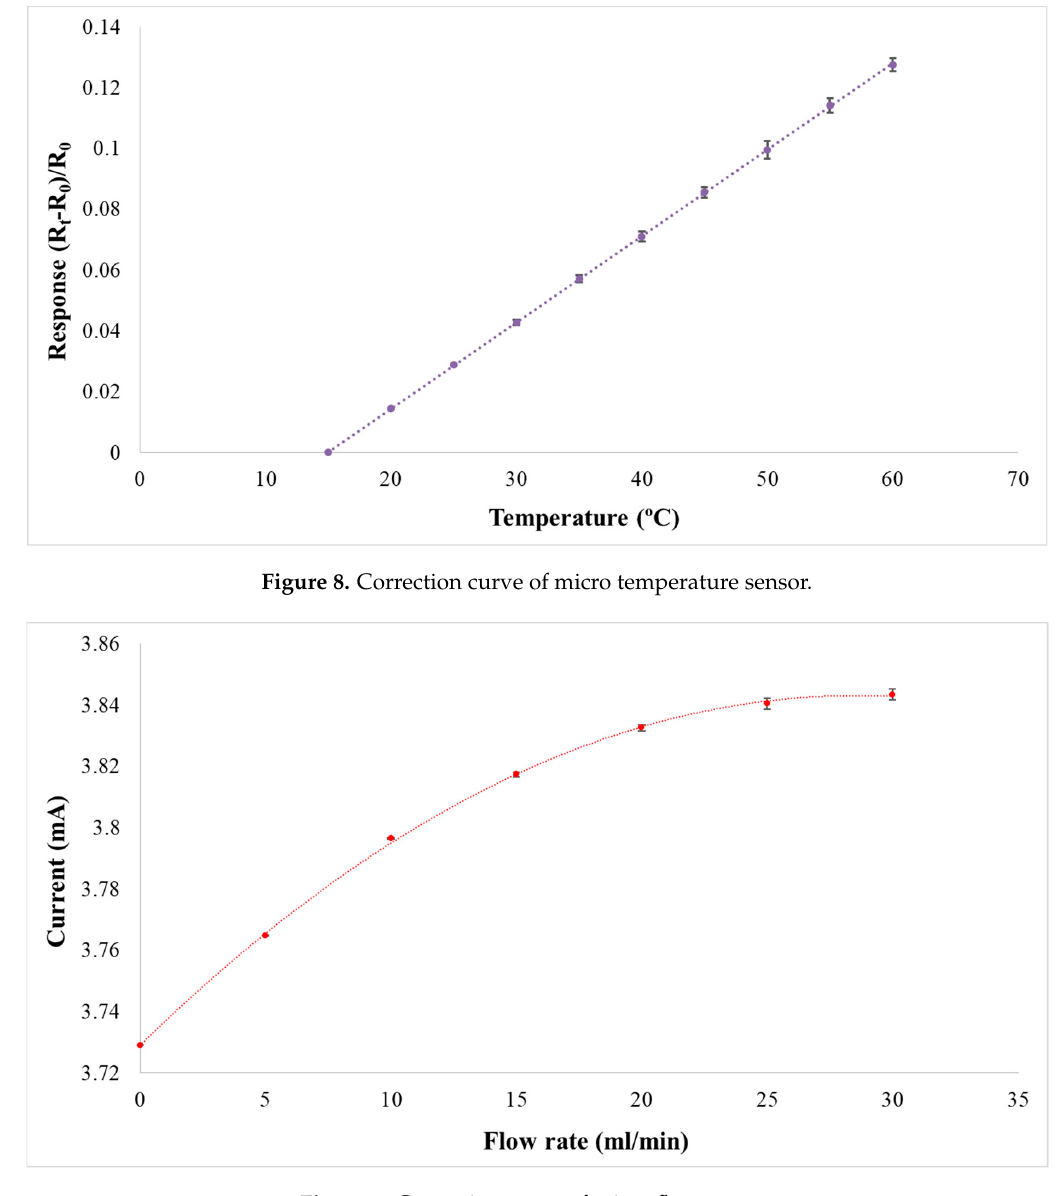
Figure 9. Correction curve of micro flow sensor.